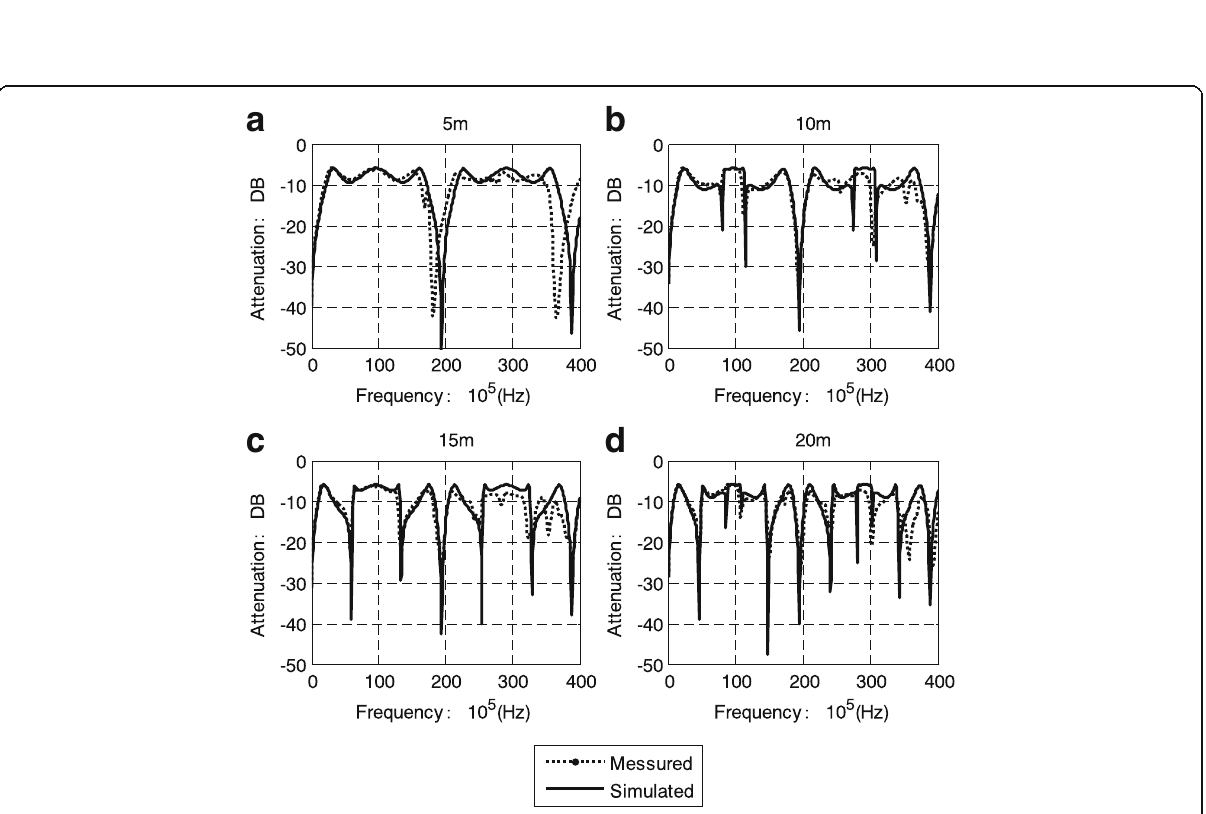
Fig. 18 Voltage transmission amplitude-frequency characteristic for various branch lengths ( a ) 5m ( b ) 10m ( c ) 15m ( d )